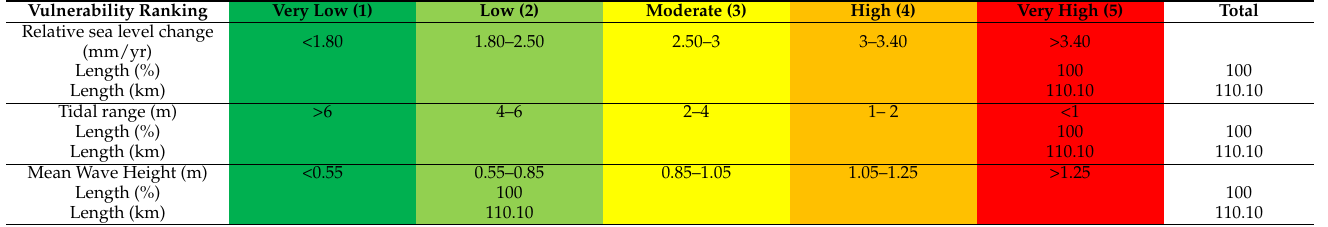
Figure 7. Map of vulnerability ranking of the physical variables: ( a ) Relative Sea Level change; ( b ) Tidal range; ( c ) Mean Wave Height. Table 3. Ranking of the physical variables: (a) Relative Sea Level change; (b) Tidal range; (c) Mean Wave Height. The tables indicate the length, in km and percentage, of coastline in each category of